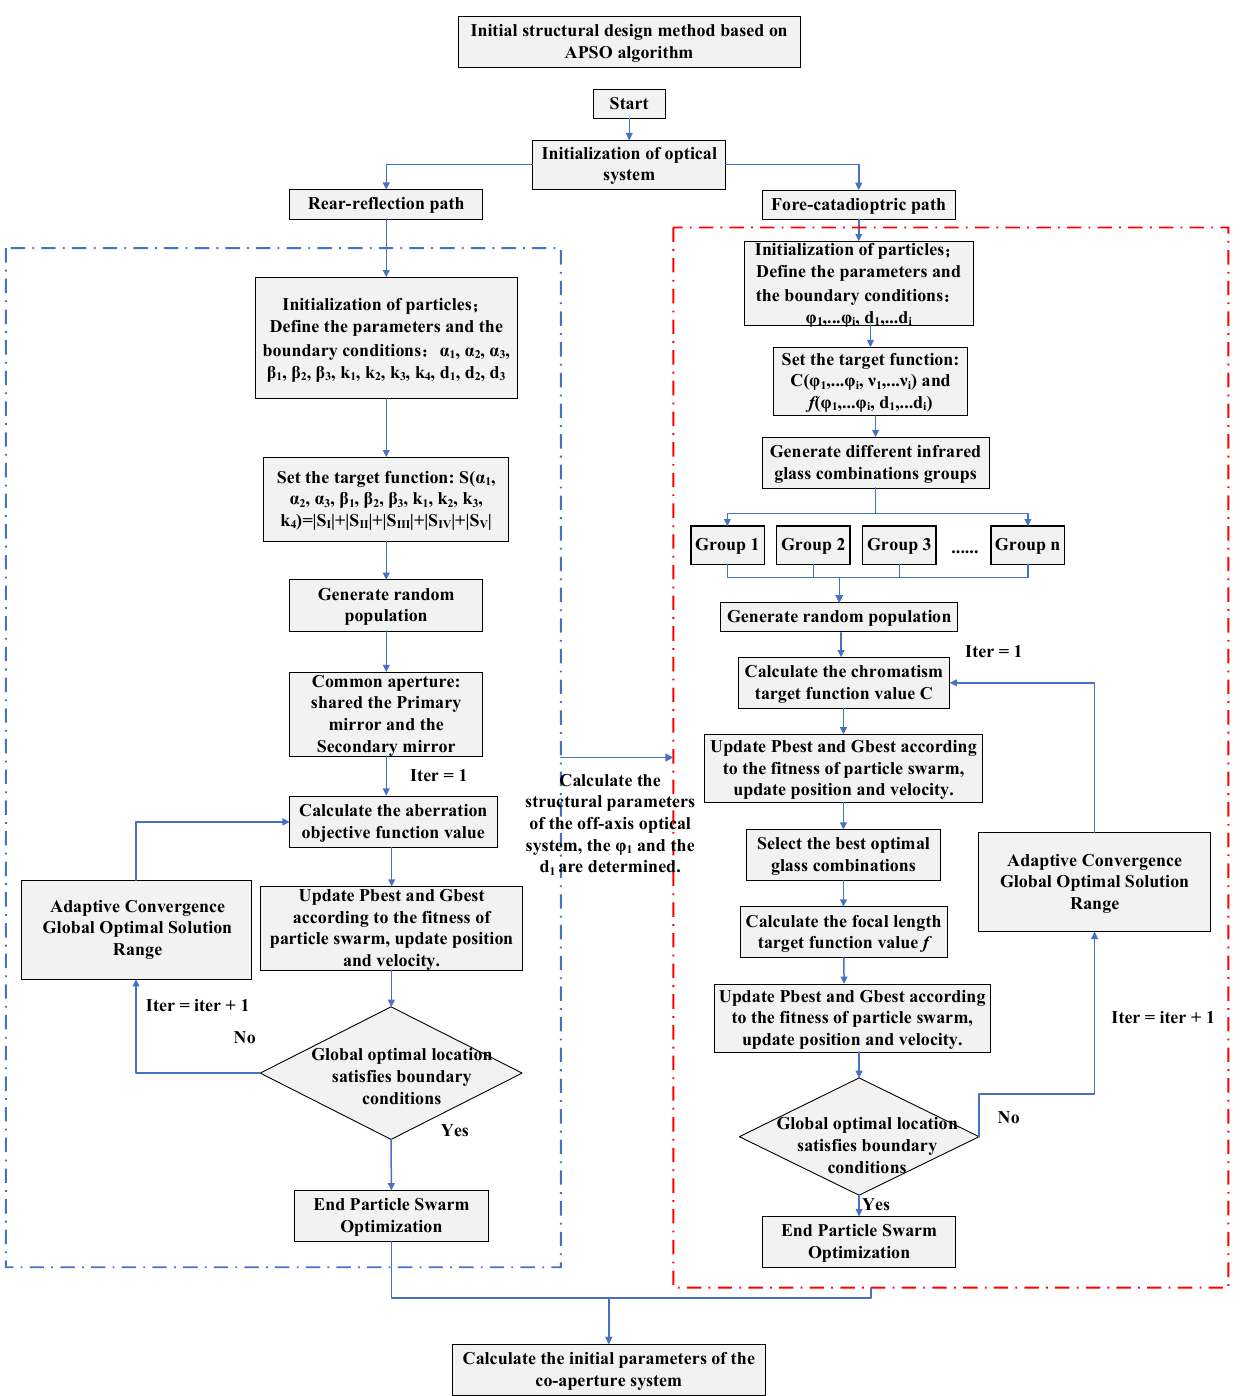
Figure 3. Flow chart of APSO algorithm.